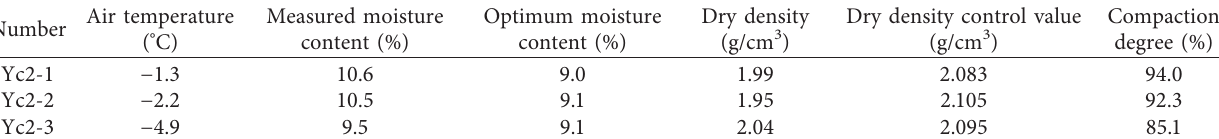
Table 2: Basic indicators after being field rolled and compacted of the filled gravelly soil.